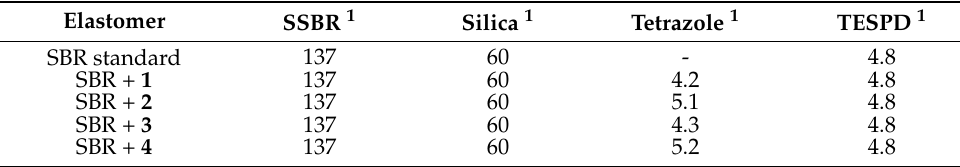
Table 2. Components of first stage elastomeric compounds.